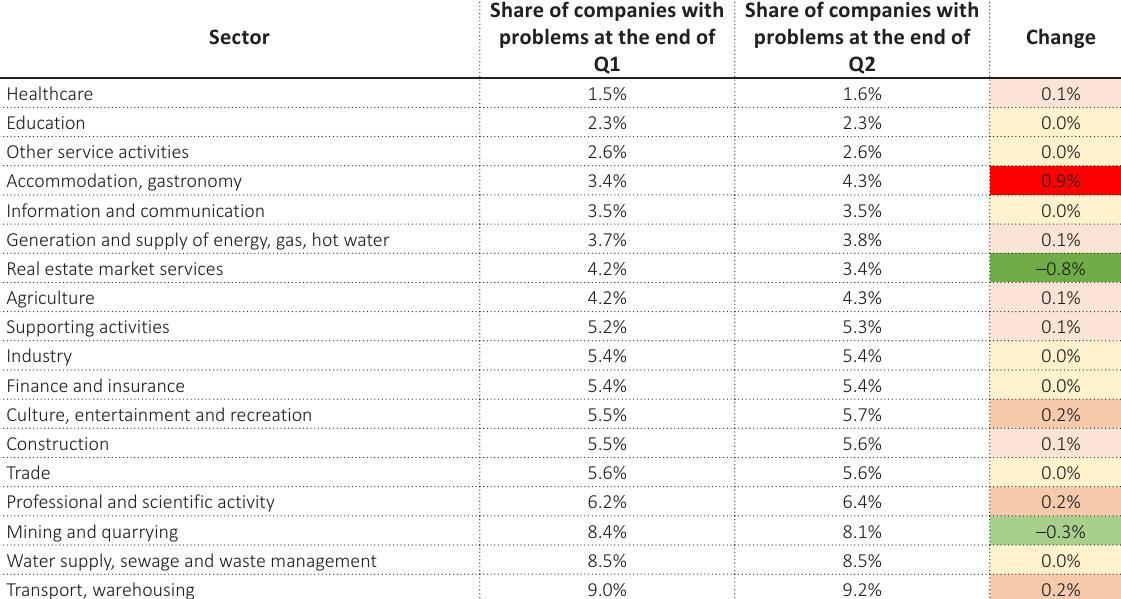
Table 2. Share of companies with problems in a given sector at the end of Q1 and Q2*